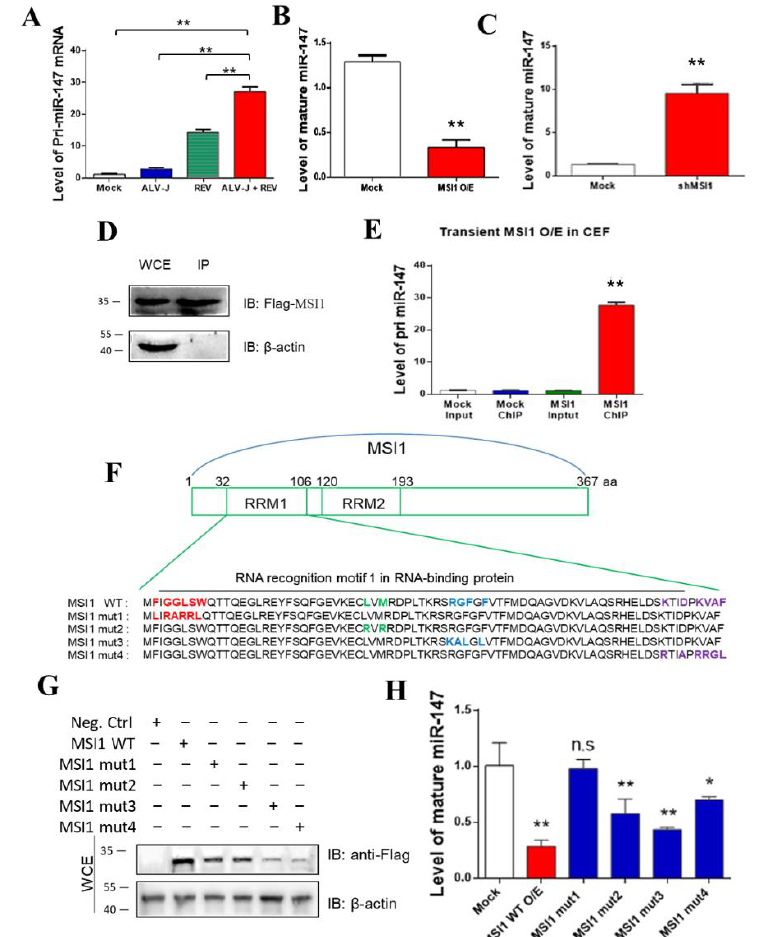
Figure 4. MSI1 directly targeted pri-miR-147 to inhibit miR-147 maturation. ( A ) ALV-J and REV synergistically elevated mRNA expression levels of pri-miR-147 in DF-1 cells, as detected using qPCR at 72 hpi. ( B ) mRNA expression level of mature miR-147 was suppressed by transfecting FLAG-MSI1 plasmid, as detected using qPCR at 48 hpi. ( C ) mRNA expression levels of mature miR-147 were increased by transfecting MSI1 Cas9/gRNA plasmid, as detected using qPCR at 48 hpi. ( D , E ) Accumulation of pri-miR-147 due to transient MSI1 expression in DF-1 cells, as detected using qPCR. Relative MSI1 expression levels were detected using WB with anti-FLAG antibody. RNA associated with immunopurified FLAG-MSI1 from DF-1 cells was analyzed using ChIP. RNA was extracted from IP material and analyzed using qPCR. ( F ) Strategy for constructing MSI1 mutants with different RRM1 regions. Original backbone of MSI1 is shown. The MSI1 mutants, including MS1 mut1 (F33L, G35R, G36A, L37R, S38R, and W39L), MS1 mut2 (L60R and M62R), MSI1 mut3 (R71K, G72A, F73L, and F75L), and MSI1 mut4 (K98R, D101A, K103R, V104R, A105G, and F106L) were constructed same colors. ( G ) All MSI mutants were successfully transfected into DF-1 cells co-infected with ALV-J only MSI1 mut1 abolished the inhibition of miR-147 maturation, as detected by qPCR at 48 hpi. Data are presented as mean ± SEM for n = 3, with each experiment being performed in triplicate. ** p ≤ 0.01 determined using Student (cid:48) s t -test versus the Neg. Ctrl. group. * p ≤ 0.05 determined using Student (cid:48) s t -test versus the Neg. Ctrl. group. n.s., not